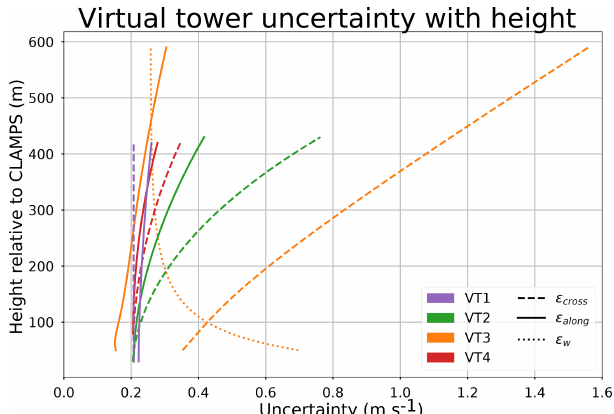
Figure 2. Uncertainty from the various virtual towers. Solid lines are uncertainty in along-valley direction, dashed lines are uncer- tainty in the cross-valley direction, and dotted lines are uncertainty in w . The color corresponds to the virtual tower (see Fig. 1). Note that most of the uncertainty is contained in the along-valley direc- tion since the CLAMPS DL was scanning at a high elevation angle (elevations used ranged from 21 to 77 ◦ ). Additionally, the further away the virtual tower was from CLAMPS (i.e., the lower the ele- vation angle had to be), the lower the uncertainty.